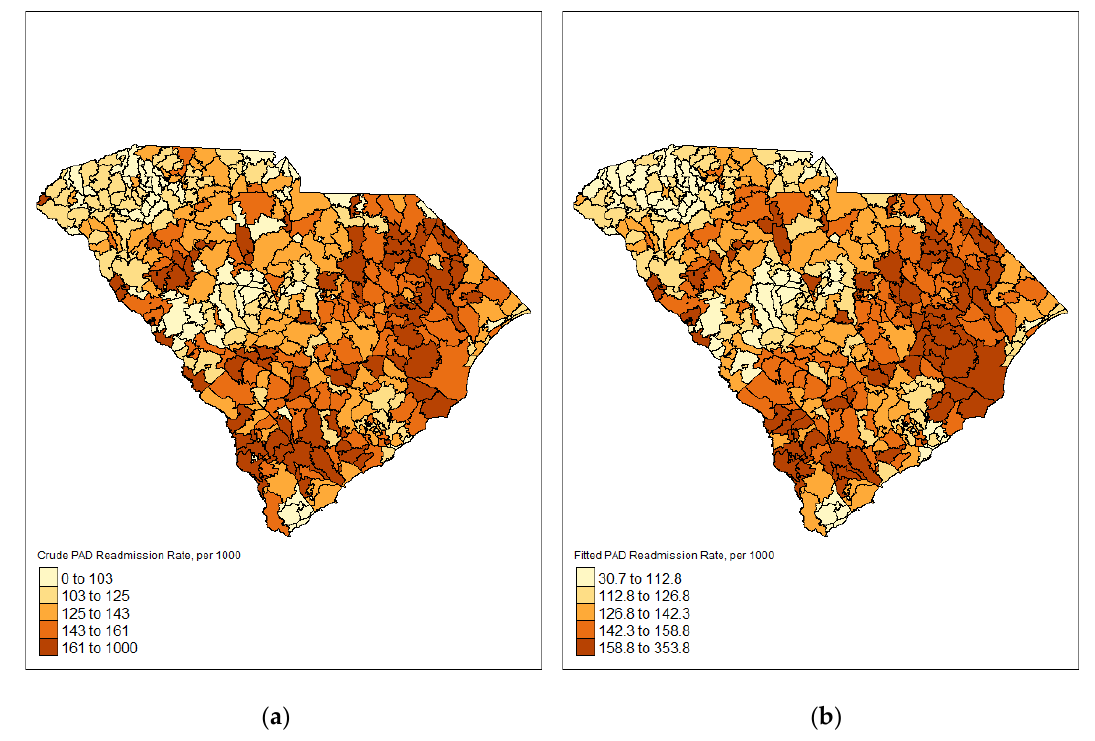
Figure 1. ZCTA level choropleth maps displaying crude and fitted readmission prevalence ( a ) Crude prevalence of PAD readmissions ( b ) Fitted prevalence of PAD readmissions.